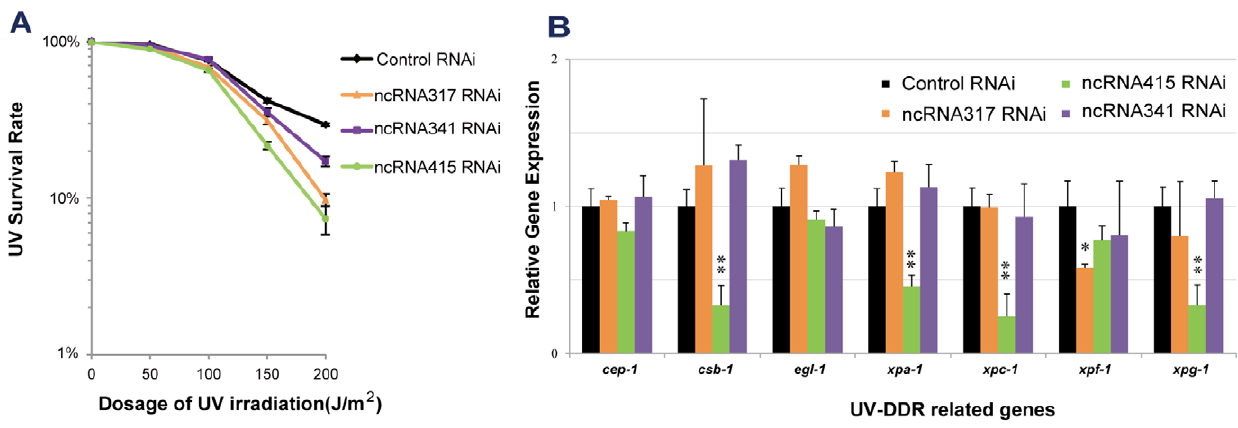
Figure 4. Three is-ncRNAs contributing to UV resistance. Candidate ncRNAs were knocked down by RNAi via feeding in wild-type worms. A, L4 larval survival following UV irradiation. Worms of L4 stage larvae were exposed to UV irradiation (0, 50, 100, 150, or 200 J/m 2 ). Worm survival was determined about 24 h after UV treatment. Each point represents the mean of three independent experiments, each performed in duplicate (typically, n . 60). Error bars denote the SEM. B, Effects of target is-ncRNAs knockdown on UV-DDR-related genes. Quantitative RT-PCR was used to detect the relative expression level of UV-DDR-related genes in RNAi-treated adult worms. Error bars show the mean 6 SEM of at least three independent experiments. *: p , 0.05, **: p , 0.01, ***: p ,